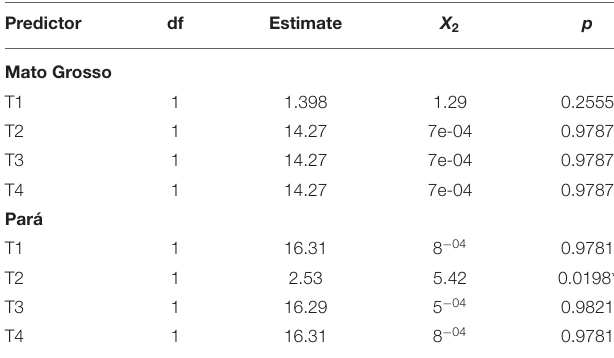
TABLE 5 | Summary of the general linear models (GLMs) of Tectona grandis seedling survival at 30, 60, and 90 days in field. Predictor df